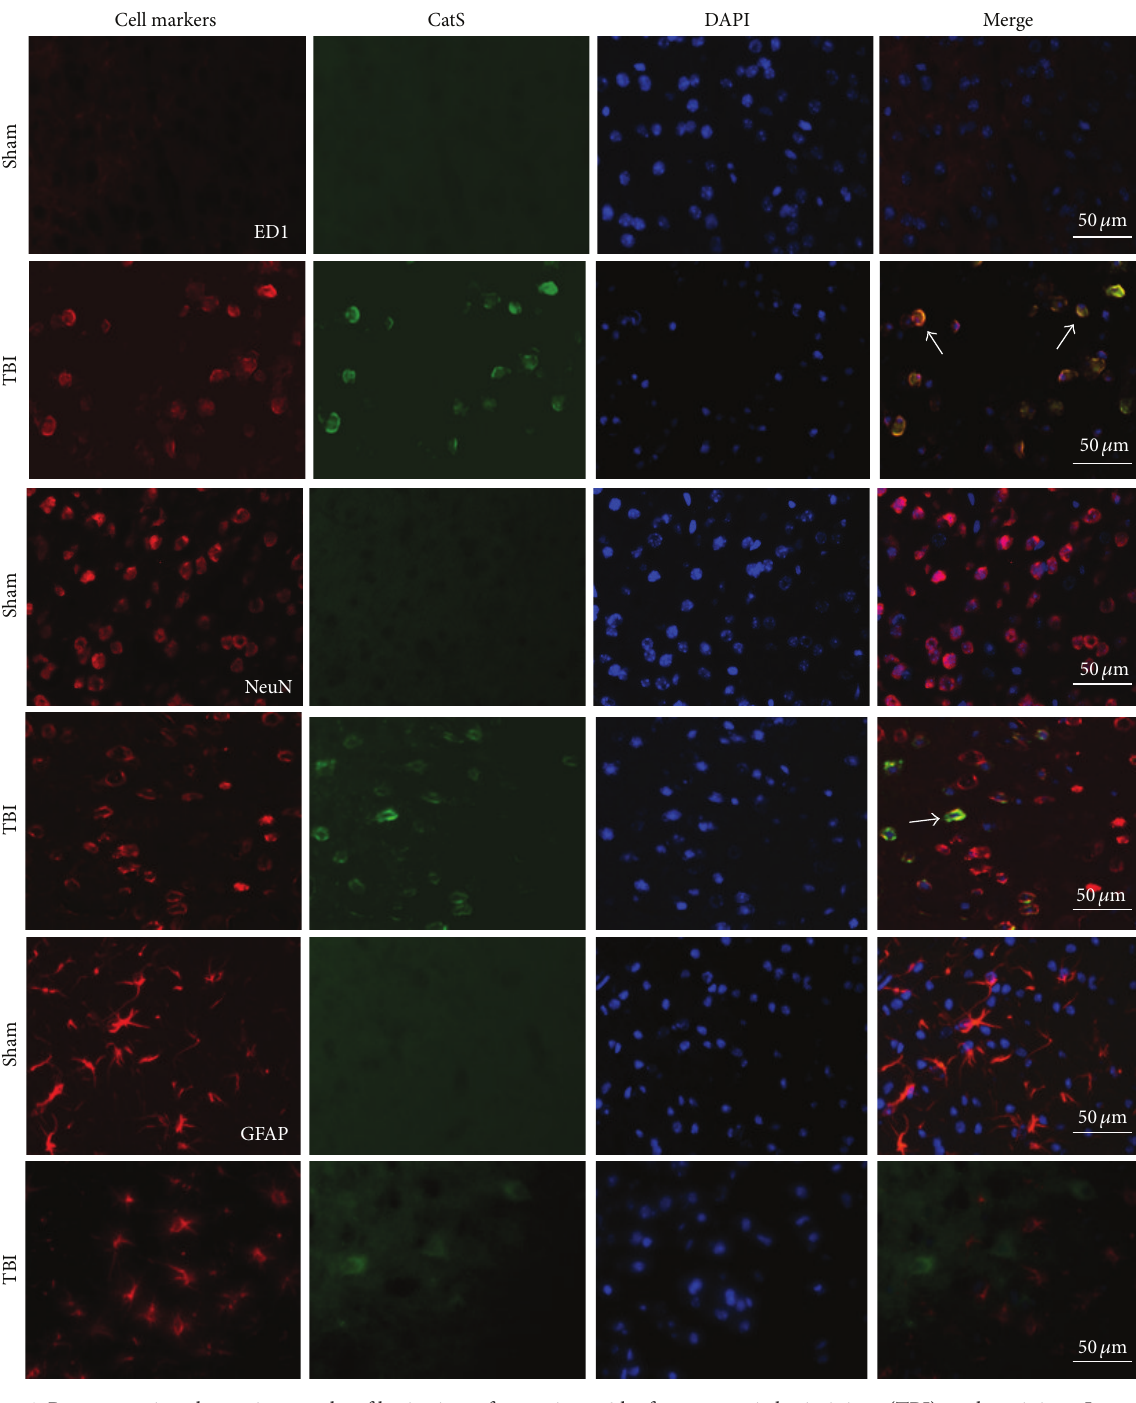
Figure 4: Representative photomicrographs of brain tissue from mice at 3h after traumatic brain injury (TBI) or sham injury. Images show double immunofluorescent staining for cathepsin S (CatS; green) and different neural cell markers (red). Nuclei were counterstained with DAPI in the same view in each section. CatS staining was weak in the sham group but enhanced in the cytoplasm of the TBI group. Arrows indicate colocalization of CatS and ED1 or NeuN. Scale bars: 50 𝜇